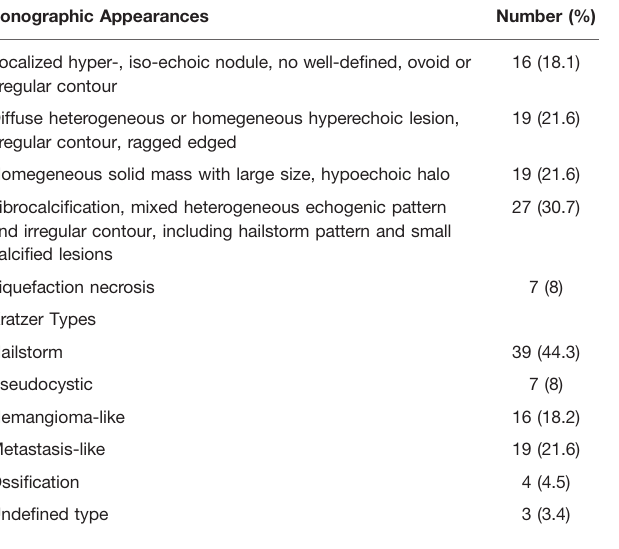
TABLE 3 | Sonographic appearances of 88 HAE